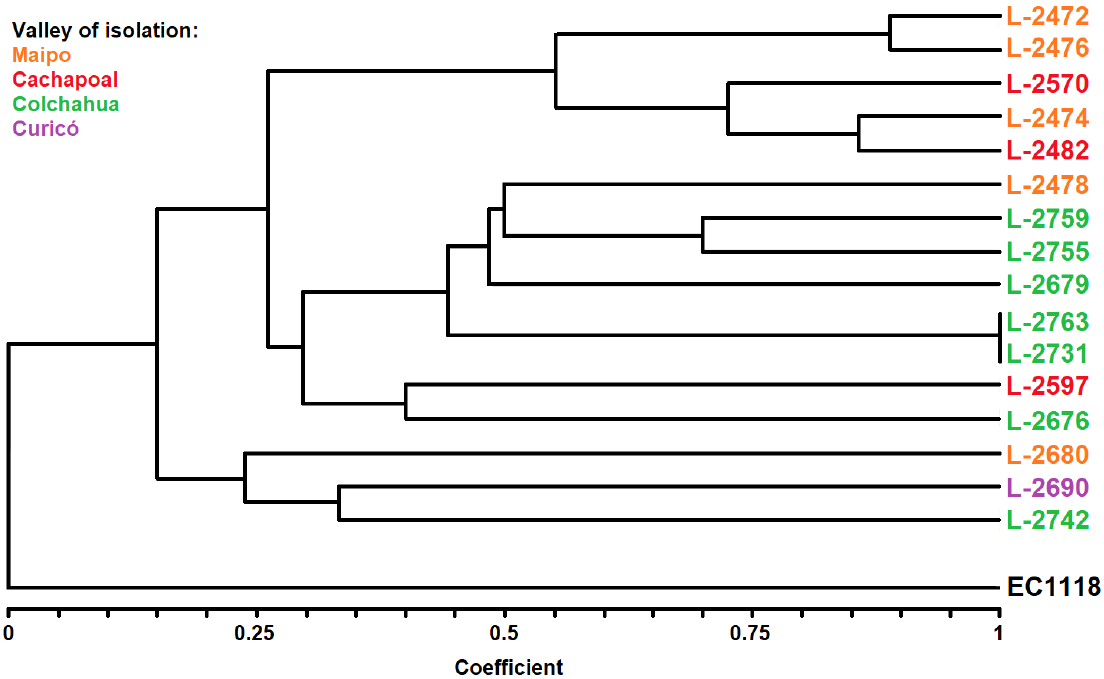
Figure 2. Dendrogram of genetic similarity among wine strains of Brettanomyces bruxellensis from Chile obtained by means of DNA fingerprinting patterns produced from RAPD technique using OPA series primers. The colors indicate the valley of origin of each strain.